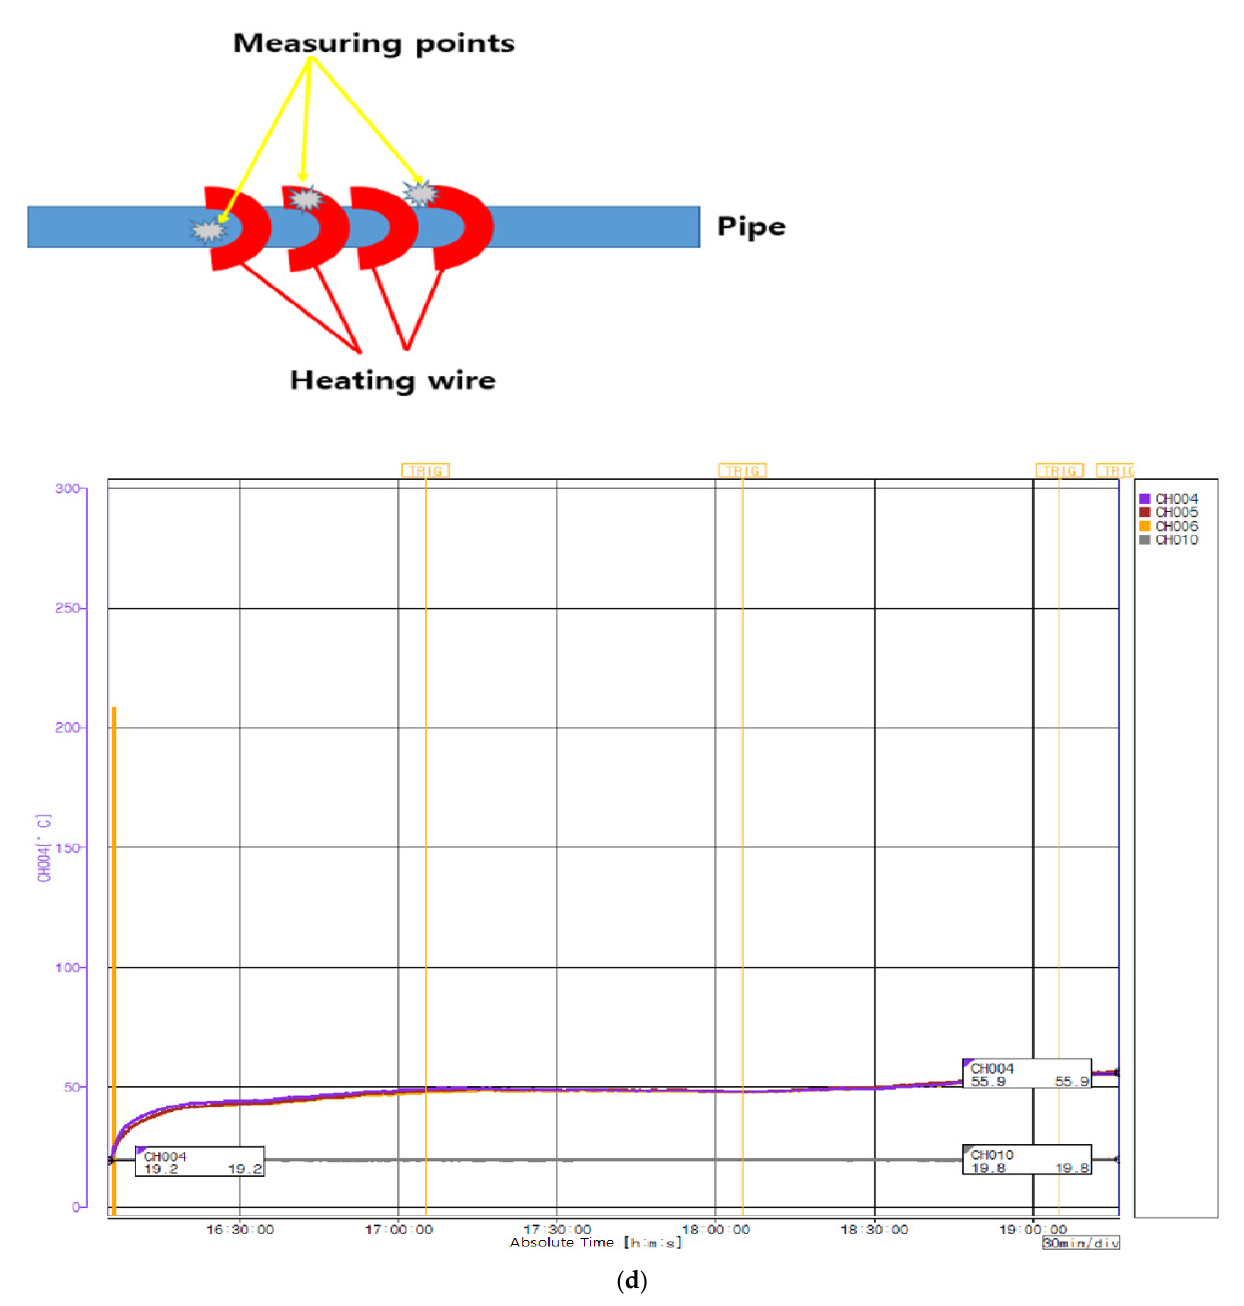
Figure 11. ( a ) Sample reproducibility test: Case 1: Heating cables wrapped around water service pipes and thermal insulation or taping on the outside. ( b ) Sample reproducibility test Case 2: Insulation around water service pipes and heating cables wrapped around them. ( c ) Sample reproduction test: Case 3: Heating cables irregularly wrapped in multiple layers around a water service pipe. ( d ) Sample reproduction test: Undetectable temperature (20 °C).